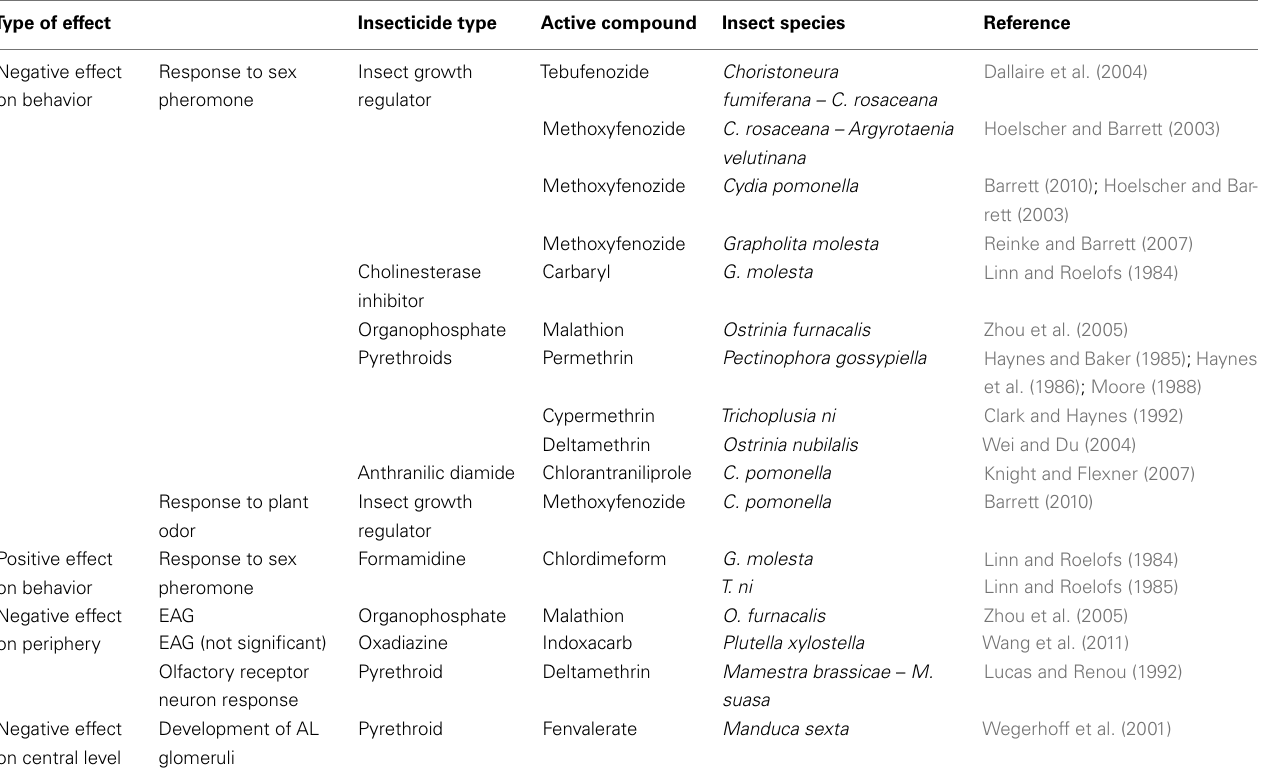
Table 1 | List of identified effects of sublethal doses of insecticides on the olfactory system of insect